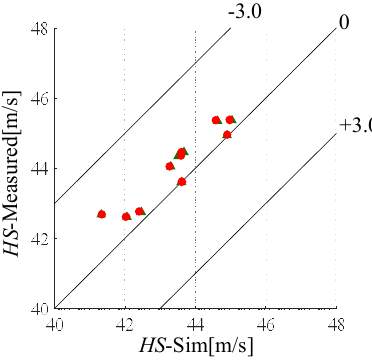
Figure 11. Comparison of measured and simulated results of HS. The triangle marks ( ▲ ) show the result without Head-torque, and the circle marks (●) show Head-torque.